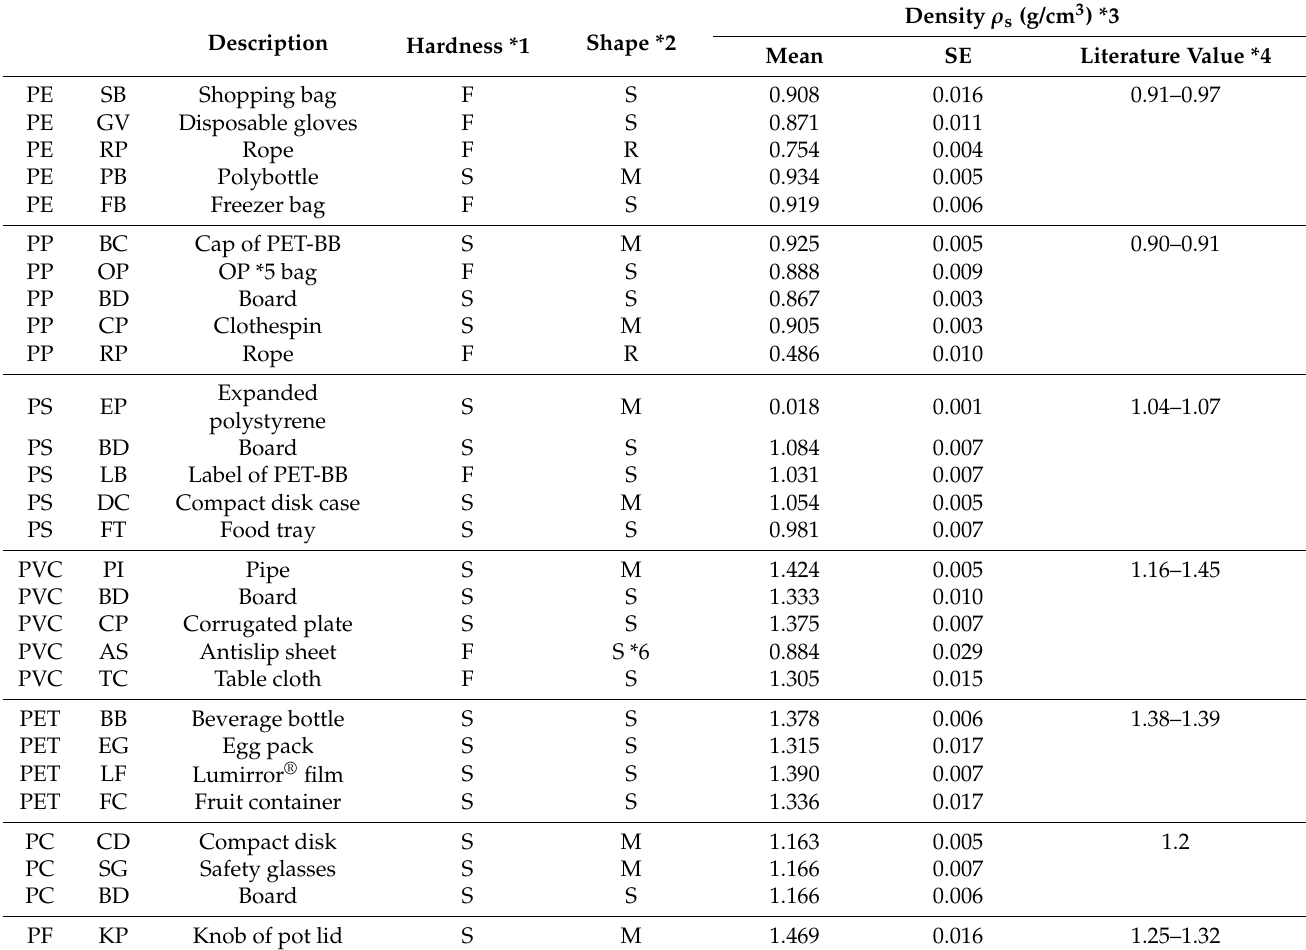
Table 1. Details of plastic samples. For example, SB is an abbreviation for shopping